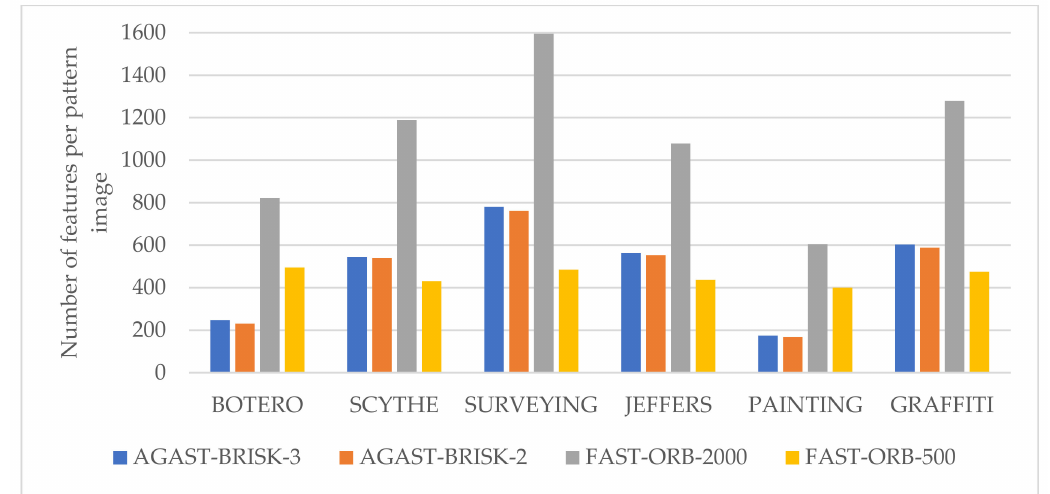
Figure 6. Clustered bar chart illustrating the number of feature points for each pattern image used in the experiments extracted by the tested detectors with different